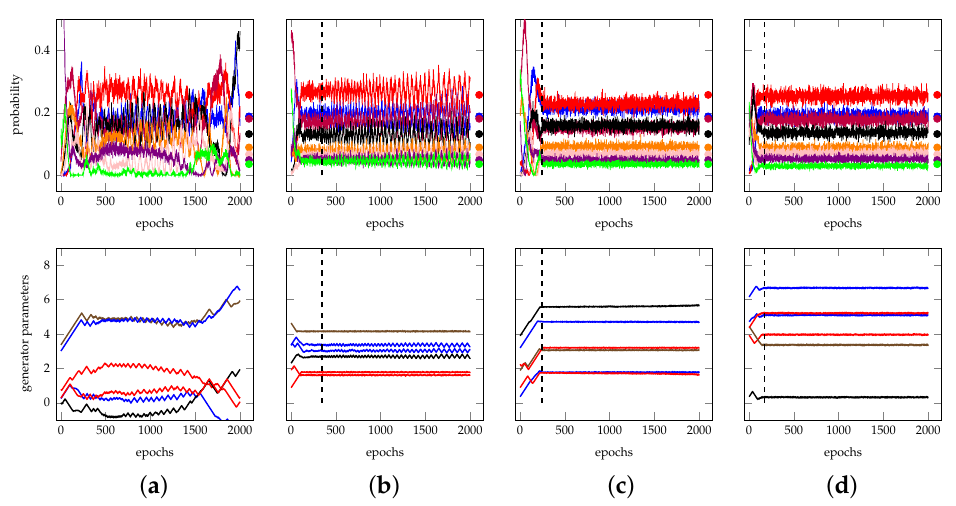
Figure 3. Different training processes, obtained with different hyper parameters and different initial random conditions. In all plots, the horizontal axis represents training time. In the top plots, each color is related to a value of the discretized random variable, the lines represent the probability density of the generated distribution, and the circles on the right represent the target distribution. In the bottom plots, the evolution of the ansatz parameters during the training. Vertical dashed lines mark the convergence epoch, as detected by our rule. More details on how runs are generated can be found in Table A2b. ( a ) A divergent run: parameters (in the bottom plot) do not stabilize. ( b ) A convergent run, with strong oscillations in the generator parameters and in the resulting distribution. ( c ) A convergent run, with poor solution quality: in the top plot, e.g., the red line and blue line are far from the target circles. ( d ) A convergent run achieving a good quality of the